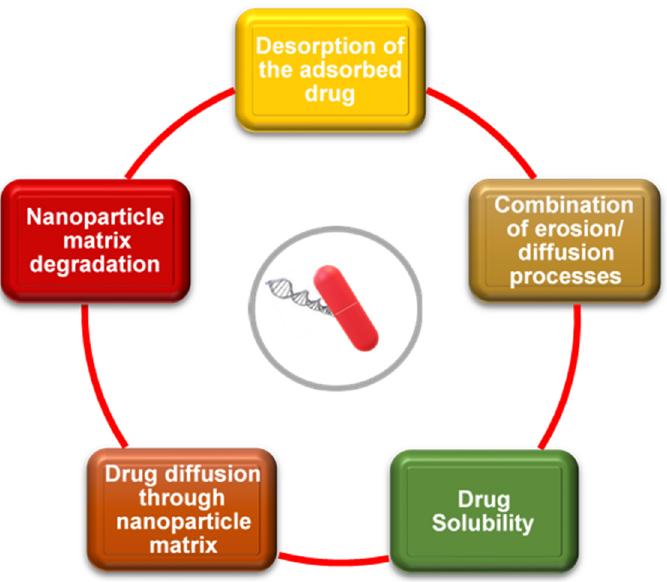
Figure 5. Important factors to consider when designing lipid nanoparticles for drug delivery. Adapted from [90]. Adapted from